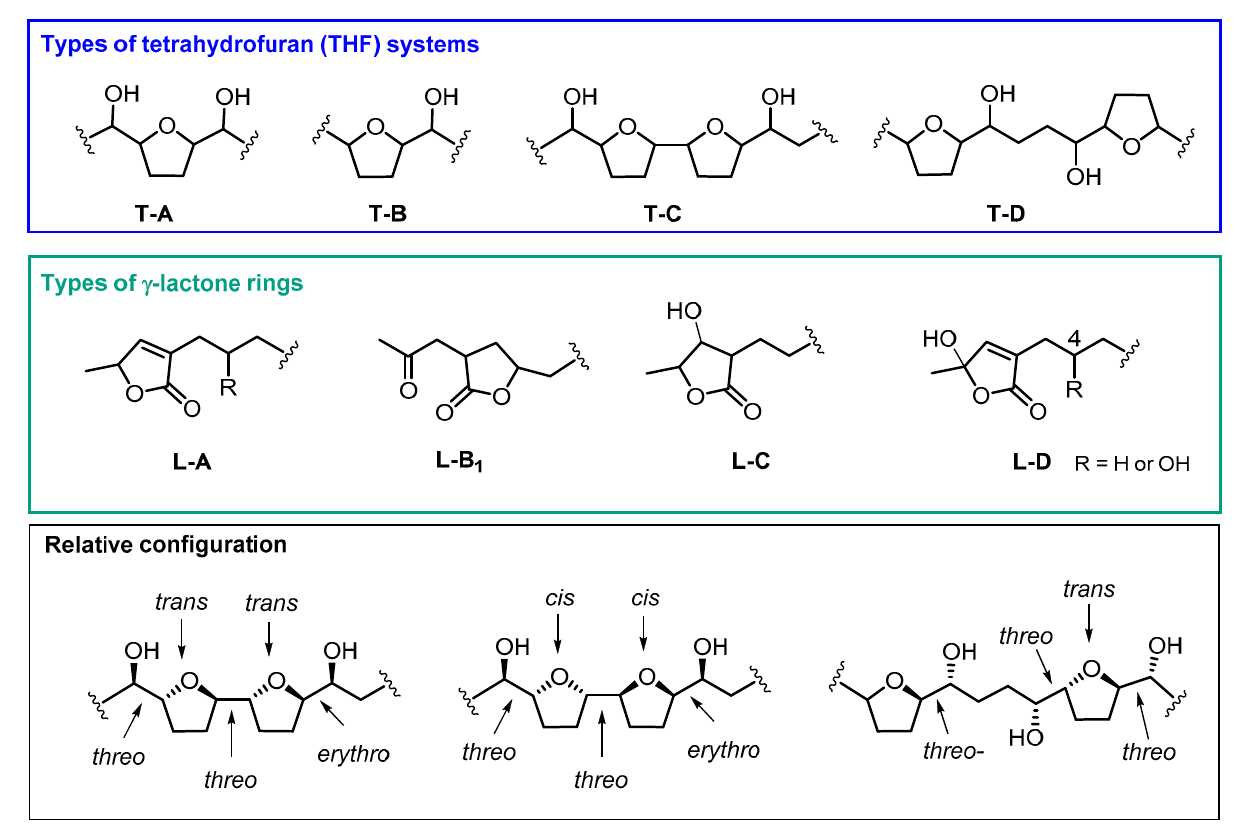
Figure 2. Most common structures of annonaceous acetogenins isolated from ACM. A total of 41 ACGs have been identified and isolated from roots, seeds, stems and, recently, from the deciduous leaves of ACM (Table 1). Of all these compounds, a total of 20 ACGs can be found in the ACMs from the Spanish ‘Tropical Coast’ region (Figure 3). Table 1. Characteristics and structural features of the 41 ACGs described in ACM.